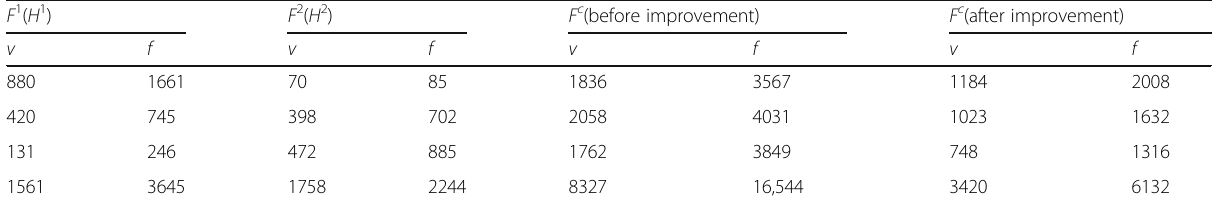
Table 1 Comparison of different fusion algorithms F 1 ( H 1